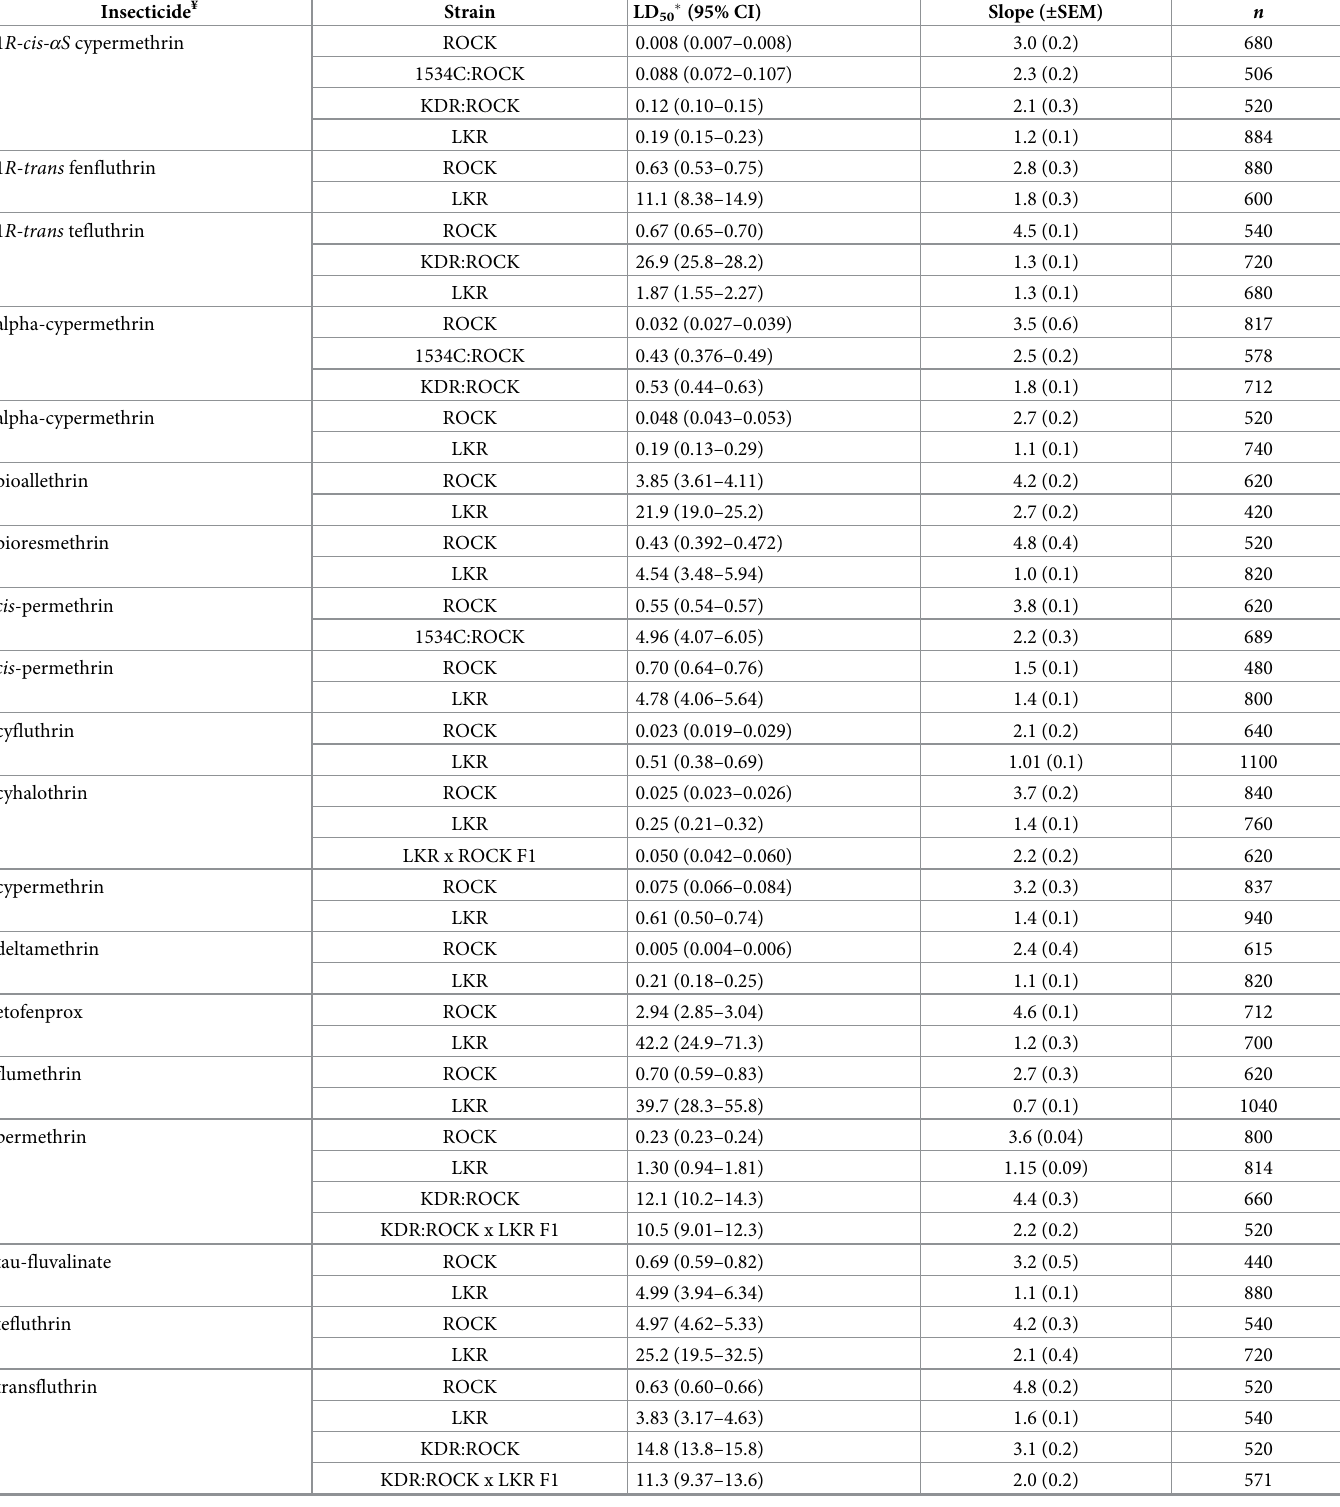
Table 3. Toxicity of insecticides that target the VSSC against susceptible (ROCK) and resistant (1534C:ROCK, KDR:ROCK and LKR) strains of A . aegypti